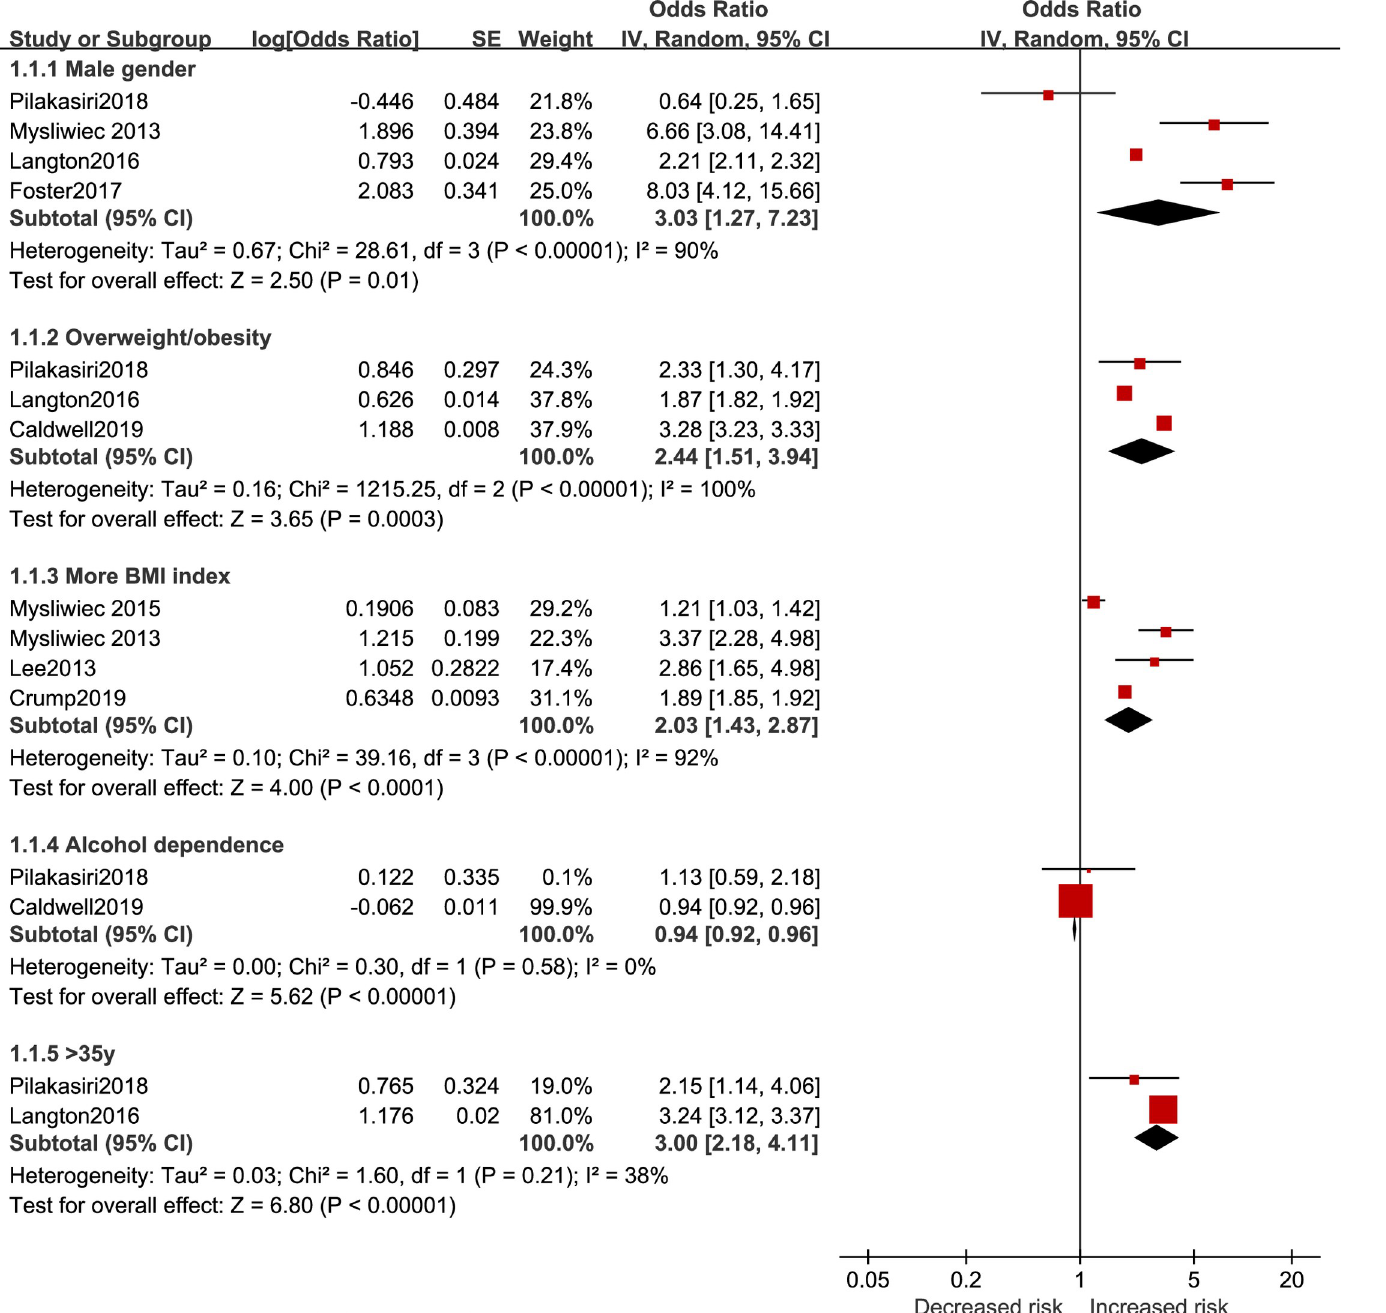
Fig 2. Sociodemographic factors for SDB in active-duty personnel.